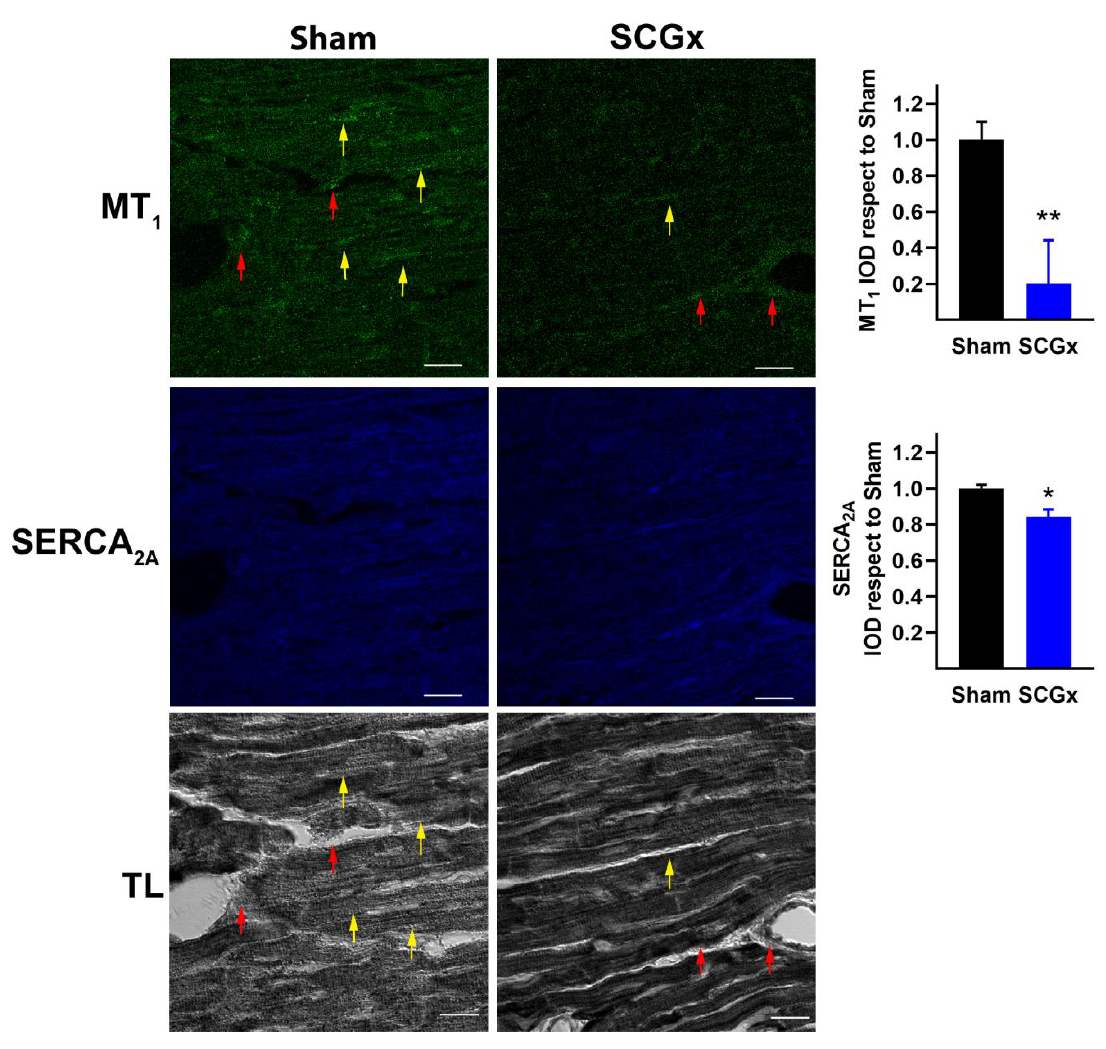
Figure 4. Melatonin receptor type 1 (MT 1 ) and SERCA 2A in myocardial tissue. Confocal immunofluorescence microscopy showed that MT 1 and SERCA 2A decreased in cardiomyocytes from the SCGx group (yellow arrows). Vascular expression of MT 1 receptors remained unchanged (red arrows). Transmitted light (TL) images showed the vascular and myocytic location of MT 1 receptors. Integrated optical density (IOD) was quantified as the area ( > 3 pixels connected) multiplied by the average intensity. Bars in the right-hand column indicate mean and SEM values relative to the level measured in the sham group. The white scale bars in the lower right corners indicate 20 µ M. In both groups, a total of 18 pictures were analyzed, six from three di ff erent hearts. * p < 0.05 and ** p < 0.01 vs. Sham by unpaired t-test with Welch’s correction.